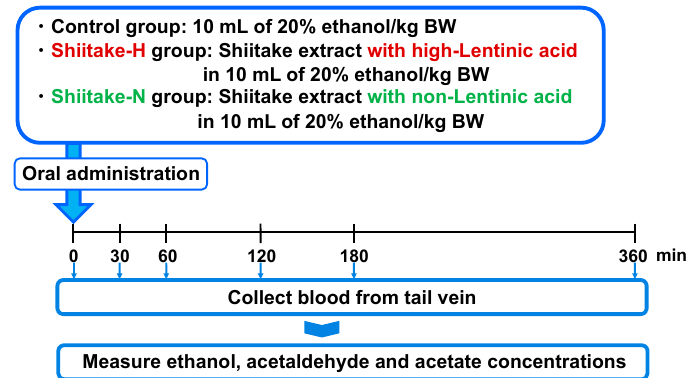
Figure 1. Experimental design to evaluate the effect of shiitake extracts on ethanol, acetaldehyde, and acetate concentrations in plasma. BW: body weight.